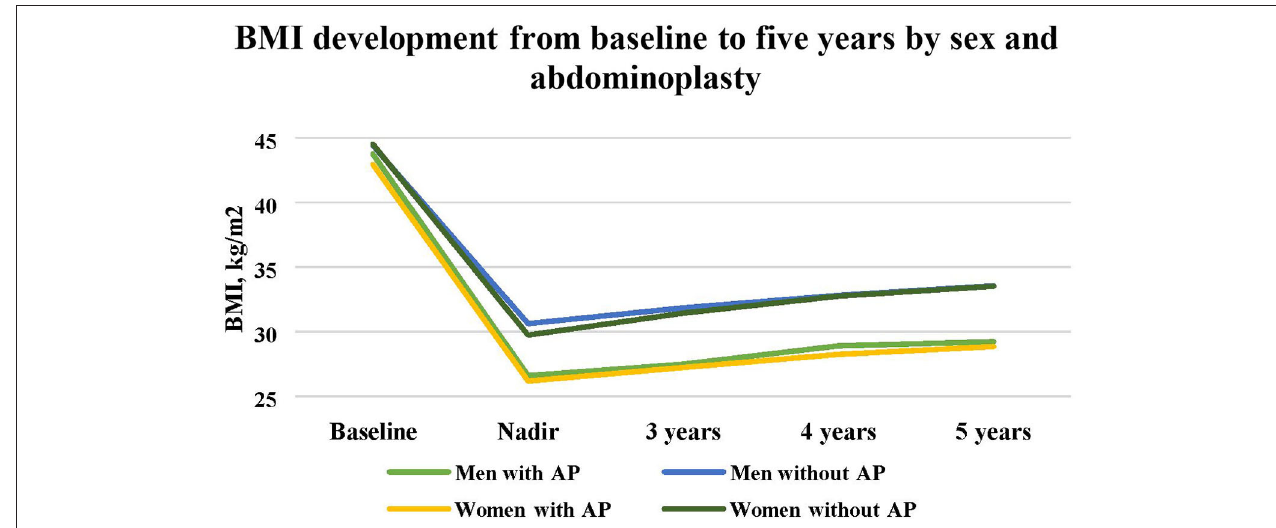
surgery have an additional beneficial metabolic effect of having